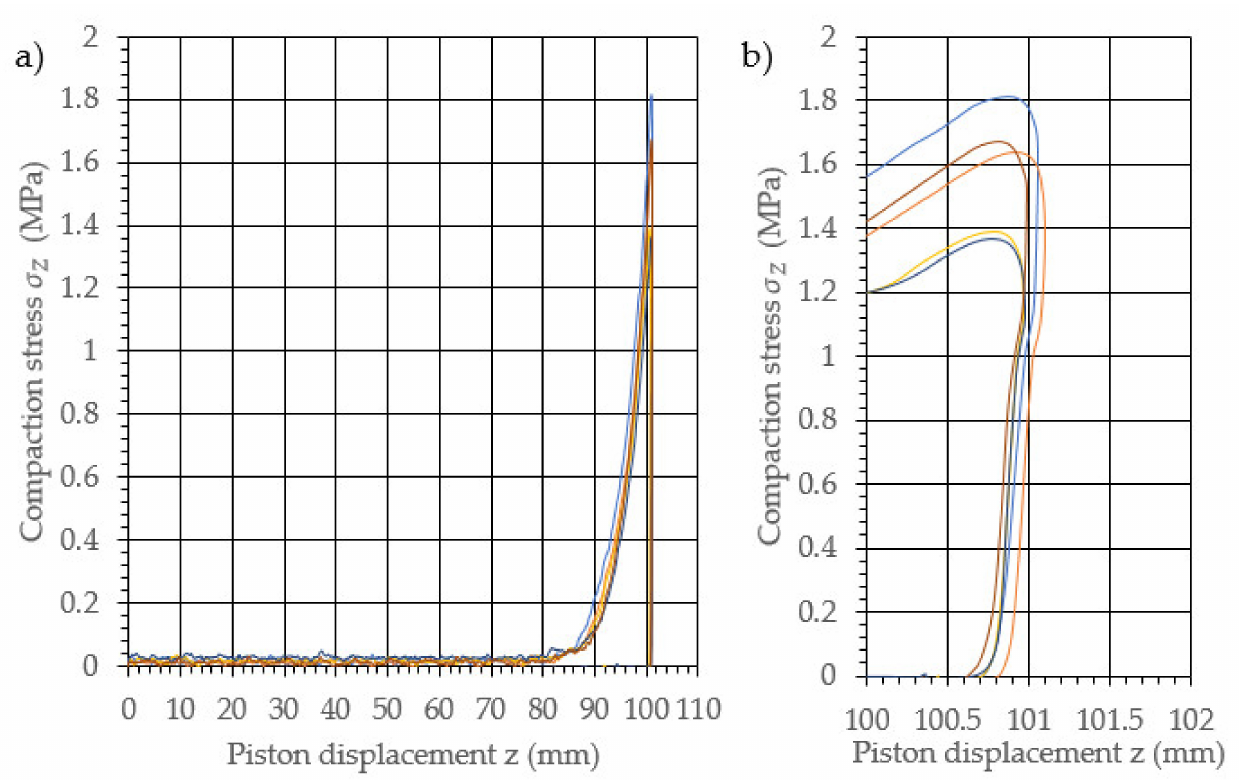
Figure 3. Characteristic curves for the compression with relaxation of dry ice with a final density of 1065.0 kg/m 3 . ( a ): The overall course of the characteristics; ( b ): an enlarged relaxation section of the compacted